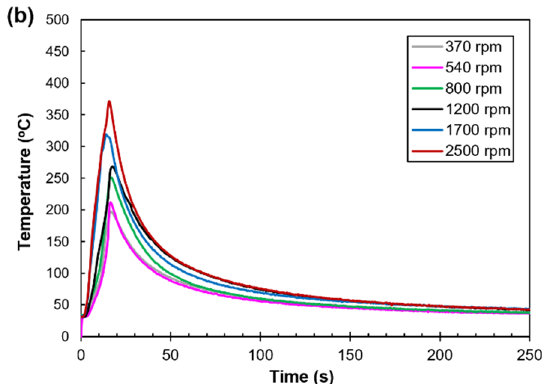
Figure 5. Weld thermal cycles at the distance of ( a ) 2 mm and ( b ) 10 mm from the interface.